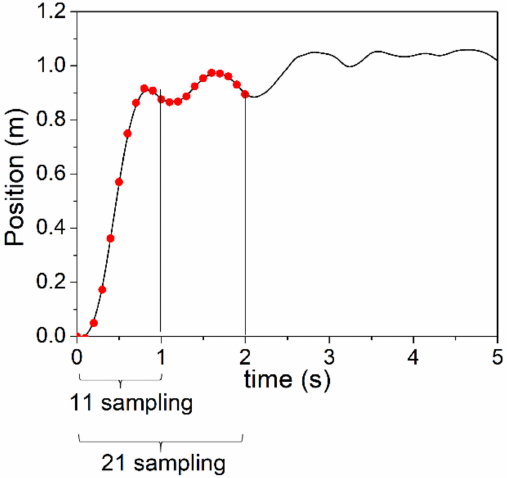
Figure 4. Sampling method for using the data as inputs when number of sampling was 11 or